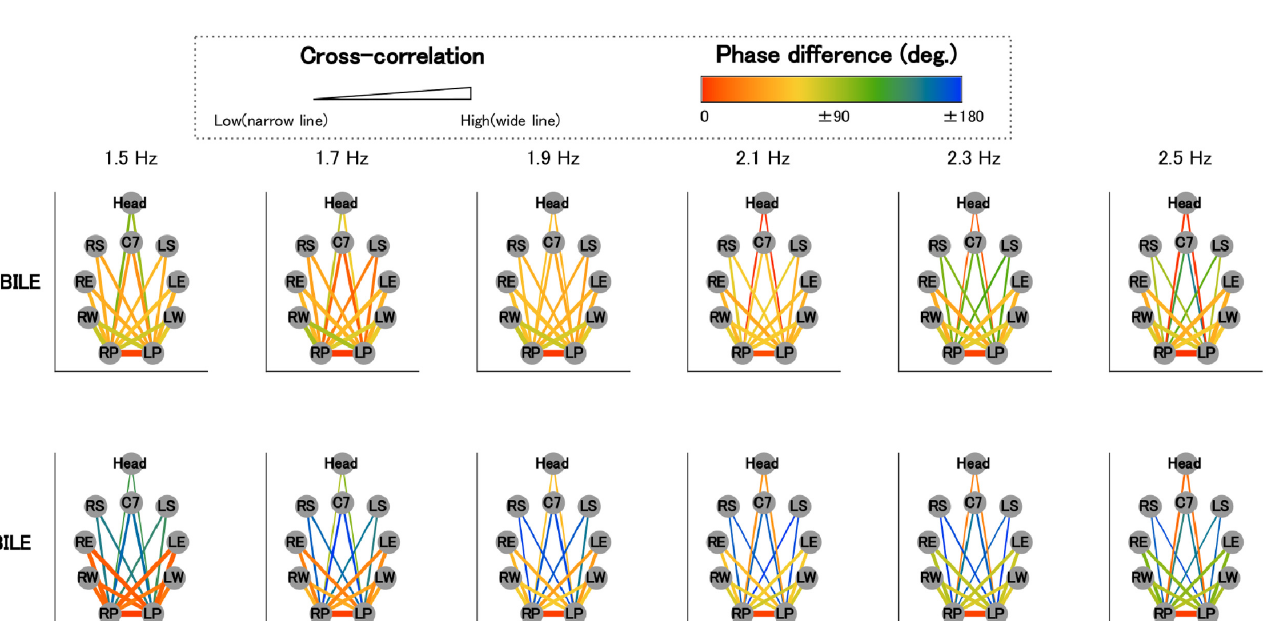
PLOS ONE | https://doi.org/10.1371/journal.pone.0262525 February 22,